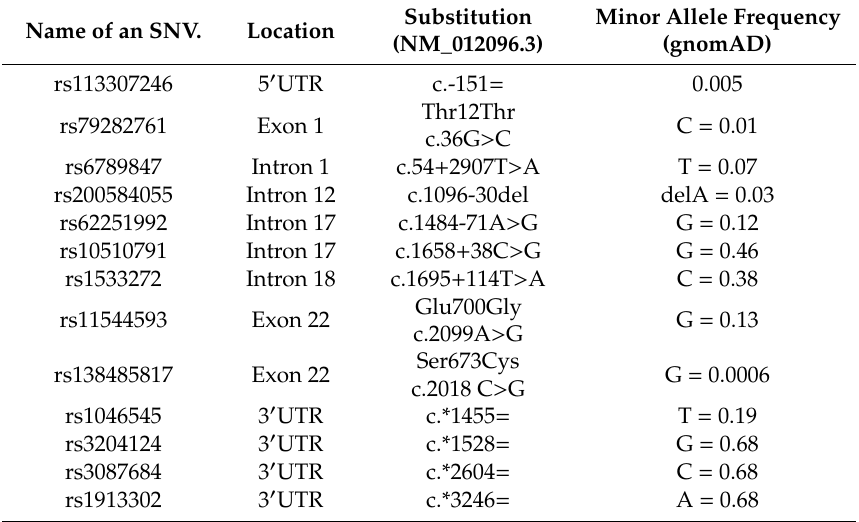
Table 1. The APPL1 gene variants among the patients with a maturity-onset diabetes of the young phenotype in Russia, and the SNVs’ (single nucleotide variants) minor allele frequency according to the gnomAD database. Name of an